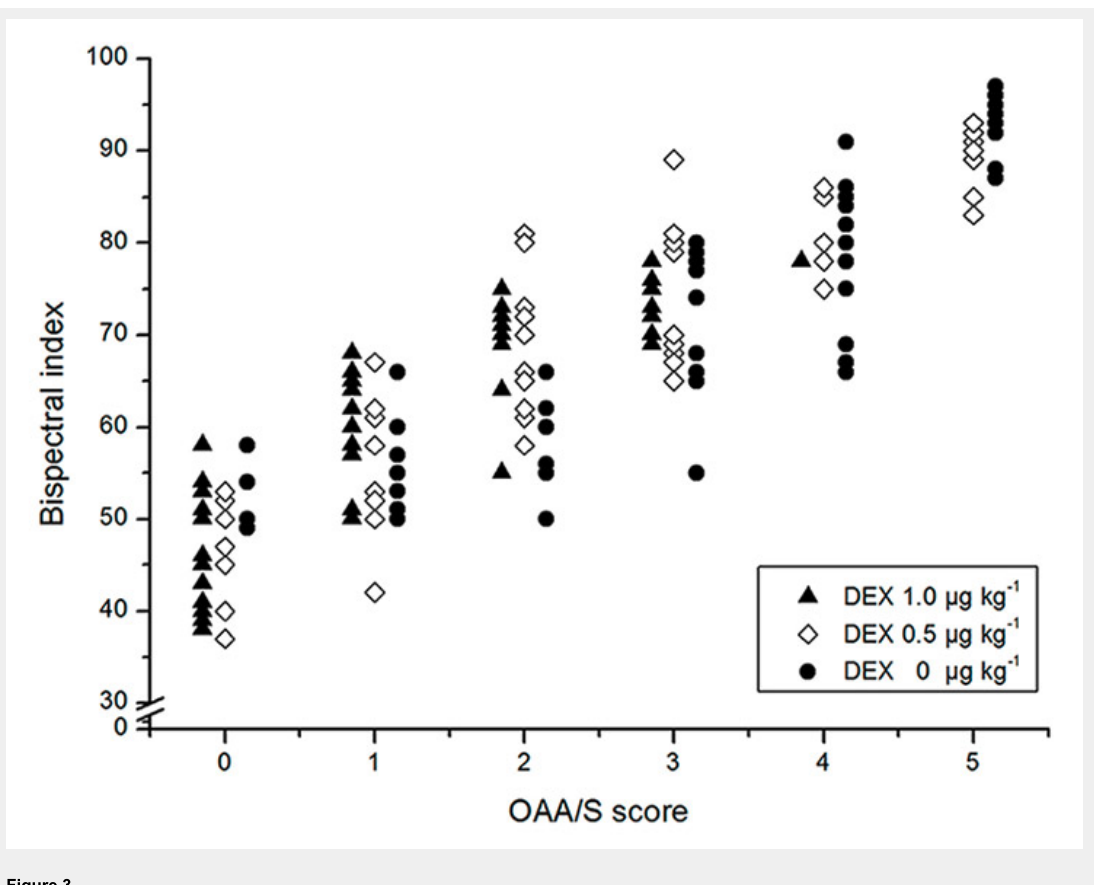
Figure 3 Raw data for the bispectral index at every Observer’s Assessment of Alertness/Sedation Scale score. (DEX =